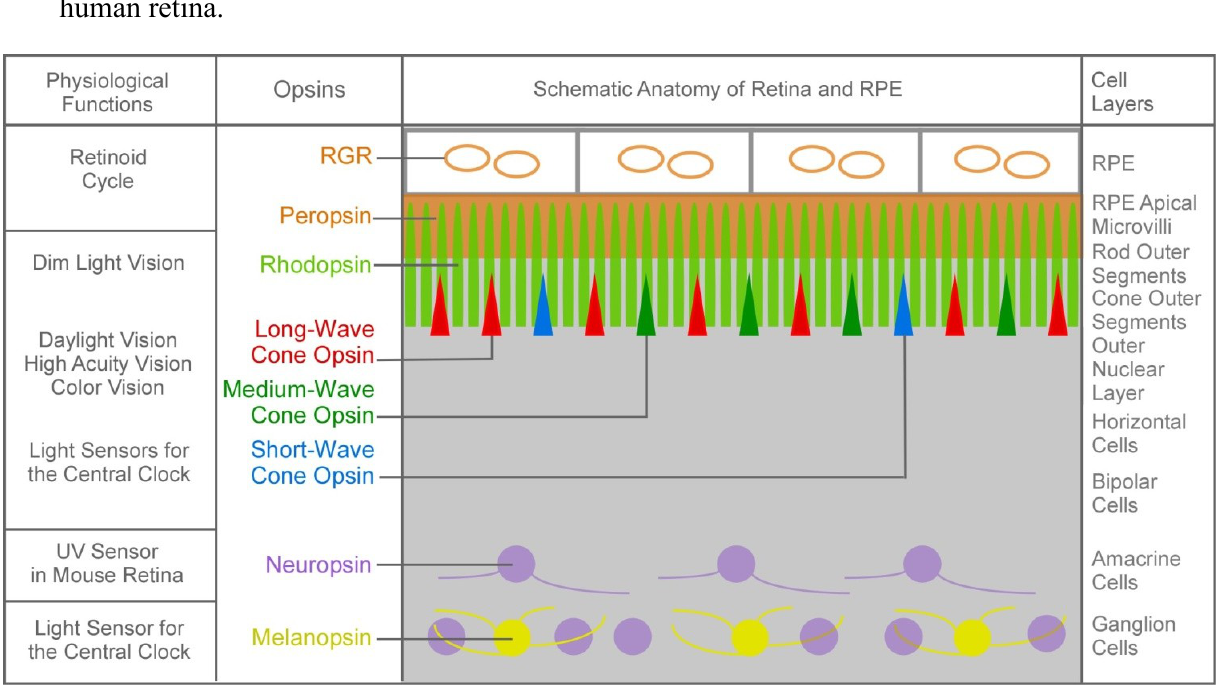
Figure 2. Schematic diagram of the localization of various opsins in human and mouse retina and retinal pigment epithelium (RPE). Only cells or cellular structures that express opsins are shown and are color-coded. There are species variations. Human, but not mouse, has the long-wave cone pigment. Neuropsin is expressed in the mouse retina, but not in the human